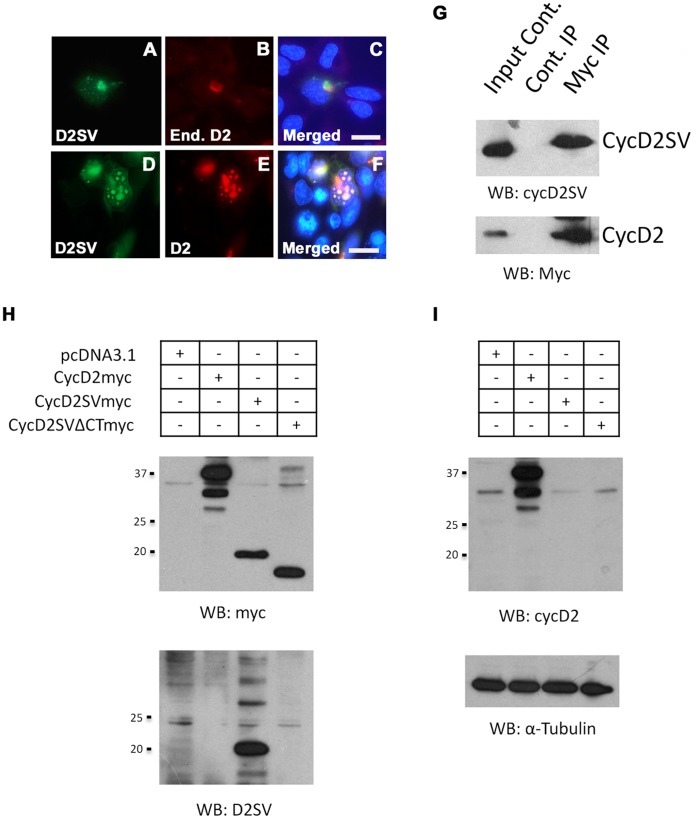
Interaction of cycD2SV with cyclin D2.Overexpressed cycD2SV co-localizes with endogenous and co-transfected cycD2. HEK293 cells transfected with cycD2SVmyc alone (A–C) or co-transfected with cycD2myc (D–F) were processed for myc (A, E), D2SV (D), cycD2 (B) immunostaining and nuclear stain (C, F). Scale bar is 20 µm. Immunoprecipitation analysis of interactions between cycD2SV and cycD2 (G). Western blot (WB) analysis performed on HEK293 cells transfected with pcDNA, cycD2myc, cycD2SVmyc and cycD2SVΔCTmyc using myc and D2SV antibodies (H) as well as cycD2 and α-tubulin antibodies (I). Results in panels H and I indicate the specificity of cycD2SV and cycD2 antibodies and rule out any cross-reactivity.